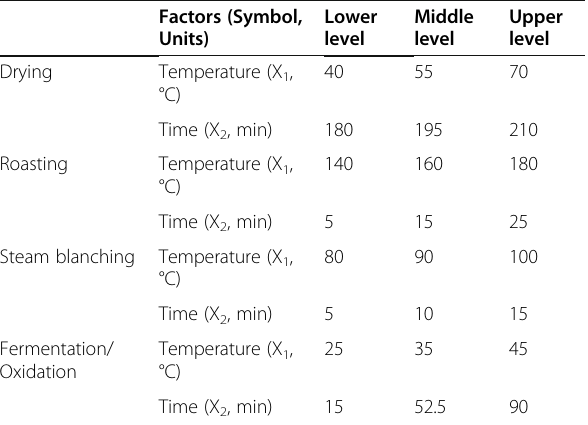
Table 1 Experimental domain and independent variables for optimization